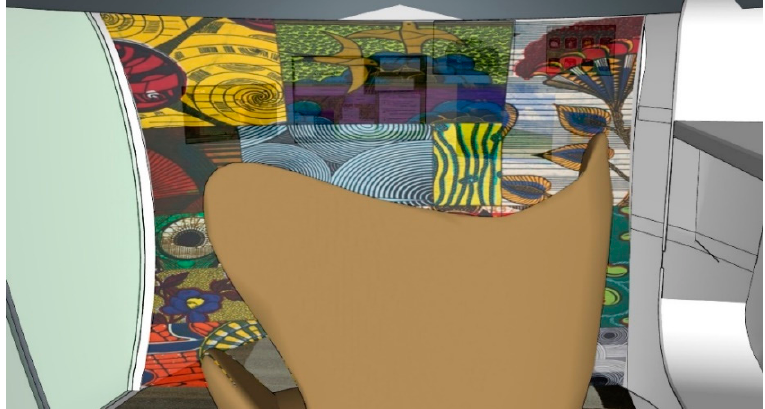
Figure 17. Another view of the Kernel of Consciousness pod.